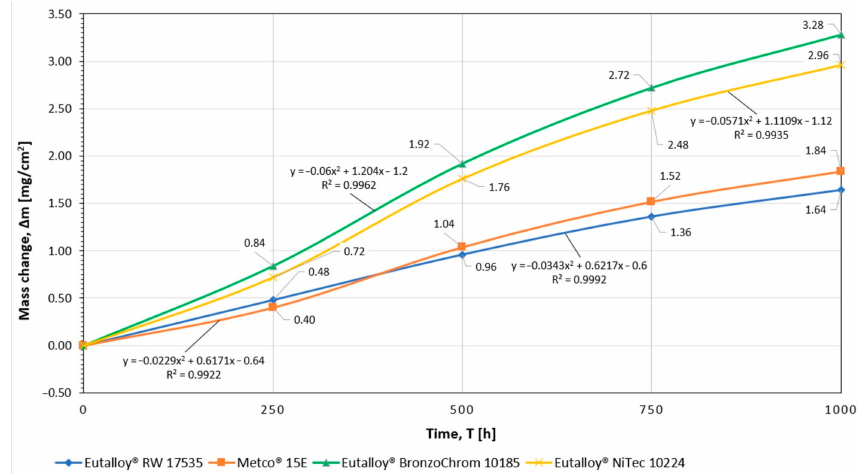
Figure 5. Graph of the unit mass change of samples protected with protective coatings as a function of exposure to a corrosive atmosphere.